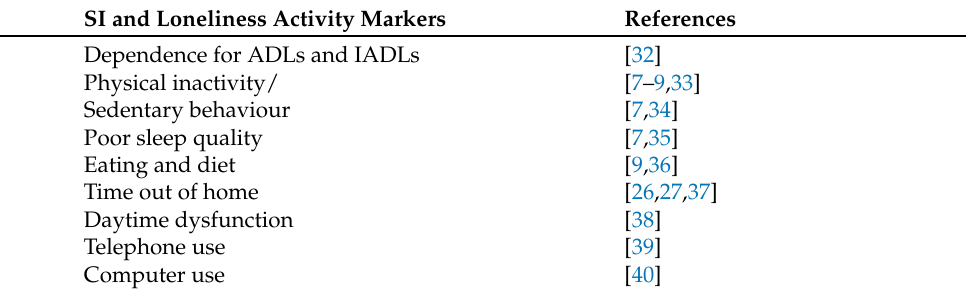
Table 1. Behavioural and activity markers of social isolation and loneliness. SI and Loneliness Activity